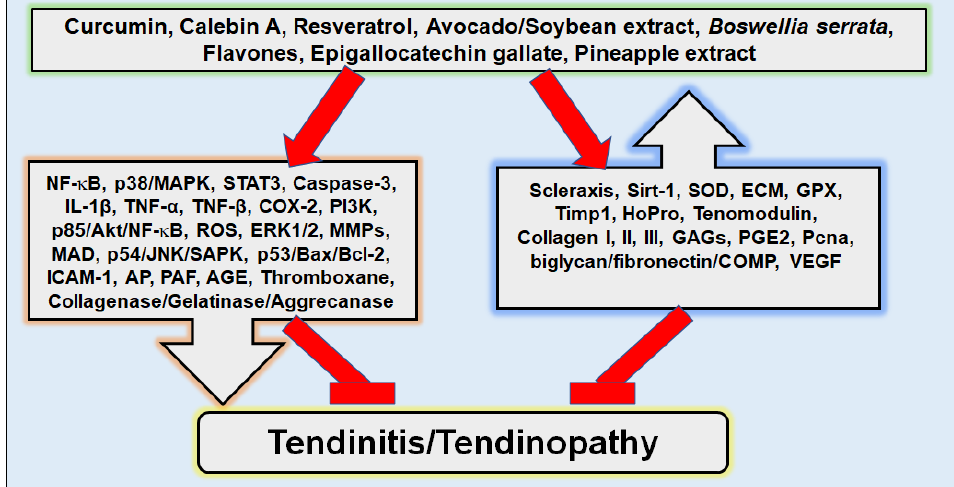
Figure 3. Distinct plant-based nutraceuticals and their regulatory mechanisms for fighting tendinitis. Various polyphenols have been demonstrated to modulate inflammatory mechanisms by downregulating major pro-inflammatory players (e.g., NF- κ B, caspase-3, MMPs, PI3K) and upregulating expression of genes required for tendon vitality and proliferation (e.g., Scleraxis, tenomodulin, collagen, Sirt-1), and thereby help to fight tendinitis. Abbreviations: AGE; advanced glycation end-products, Akt; serine/threonine kinase B, AP; alkaline phosphatase, Bax; Bcl-2-associated X protein, Bcl-2; B-cell lymphoma 2, COMP; cartilage oligomeric matrix protein, COX-2; cyclooxygenase-2,